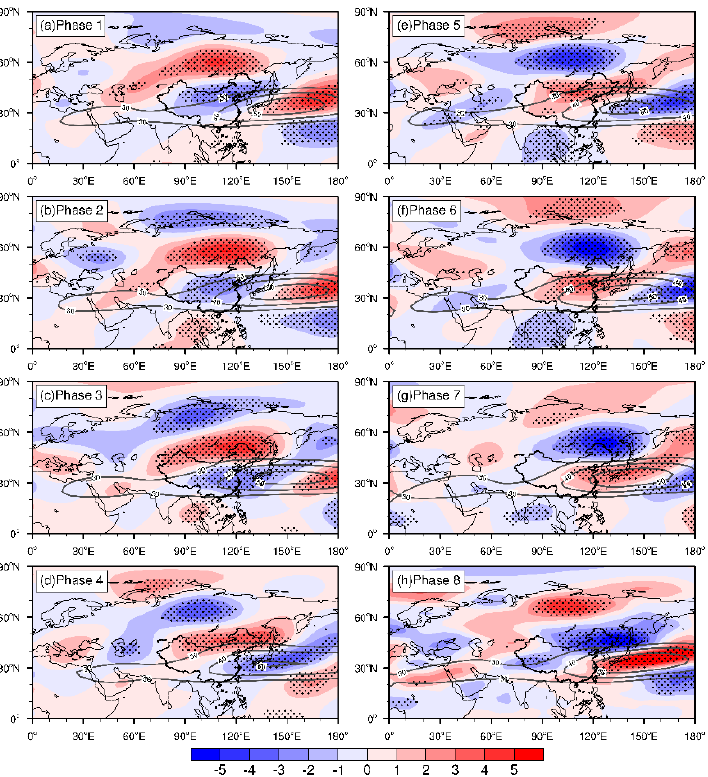
Figure 6. Phase evolution of 300 hPa zonal wind (shading: 10–30 d filtered; contour: unfiltered; unit: m/s) of LECEs (( a – h ), dotted area passes the 95% significance level).